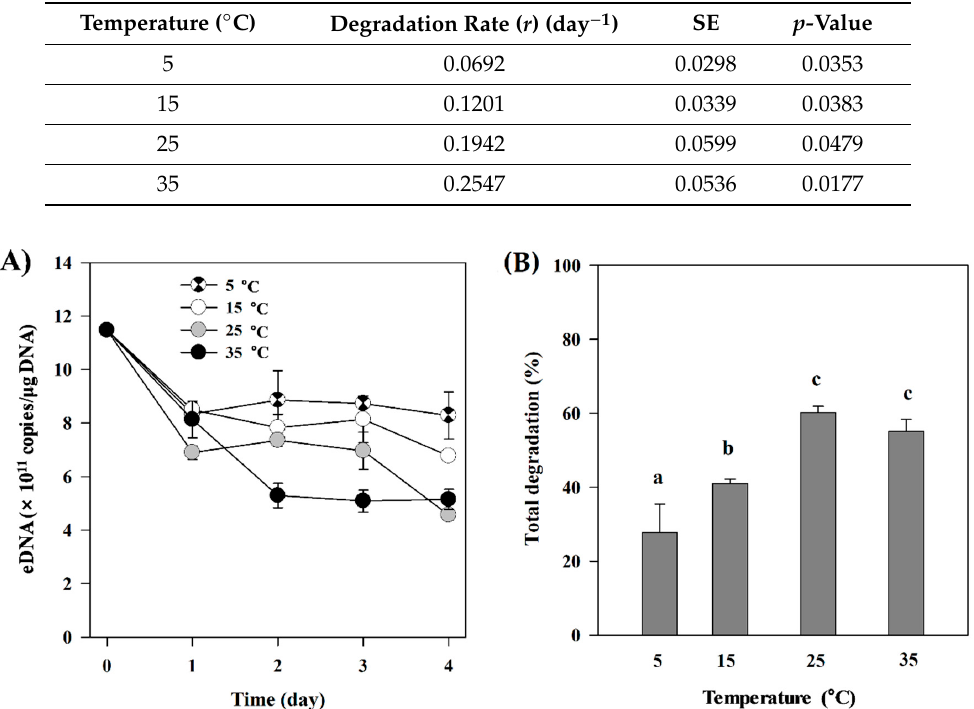
Figure 1. ExDNA concentration in samples exposed to different temperatures. ( A ) Changes in exDNA concentration detected under different temperature treatments (5 °C, 15 °C, 25 °C, and 35 °C). ( B ) Total exDNA degradation (%) at the end of the experiment (4 days). Different letters indicate statistically significant differences defined by p < 0.05 between treatments. Error bars represent the standard deviations among replicates within the treatments.